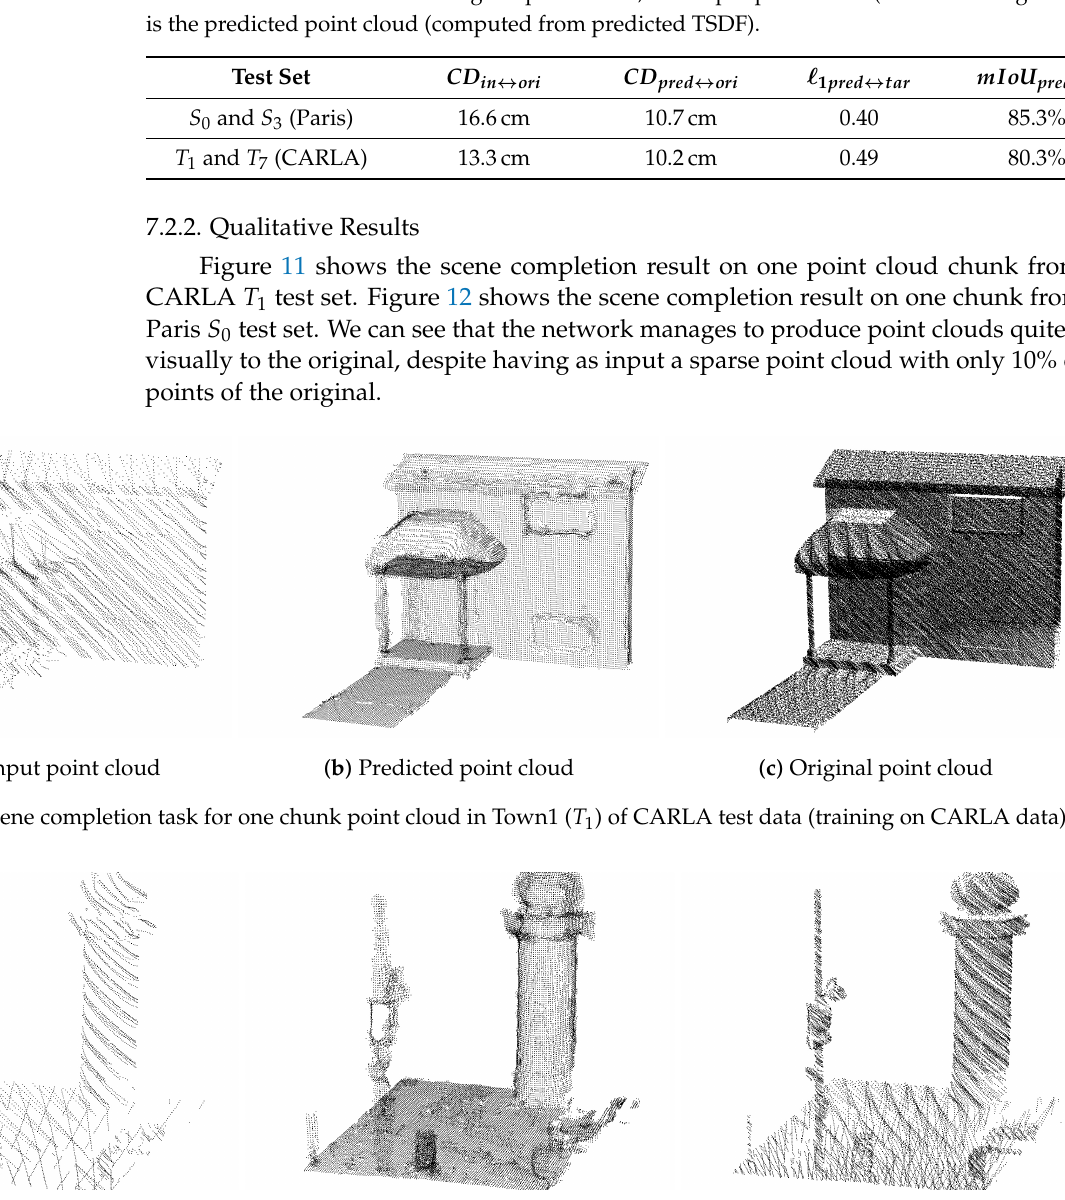
Figure 12. Scene completion task for one chunk point cloud in Soufflot0 ( S 0 ) of Paris test data (training on Paris data). training on CARLA then fine-tuning on Paris, allowing allows us to obtain a better the best 506 predicted TSDF ( ‘ 1 and mIoU ) and point cloud (Chamfer Distance). 507